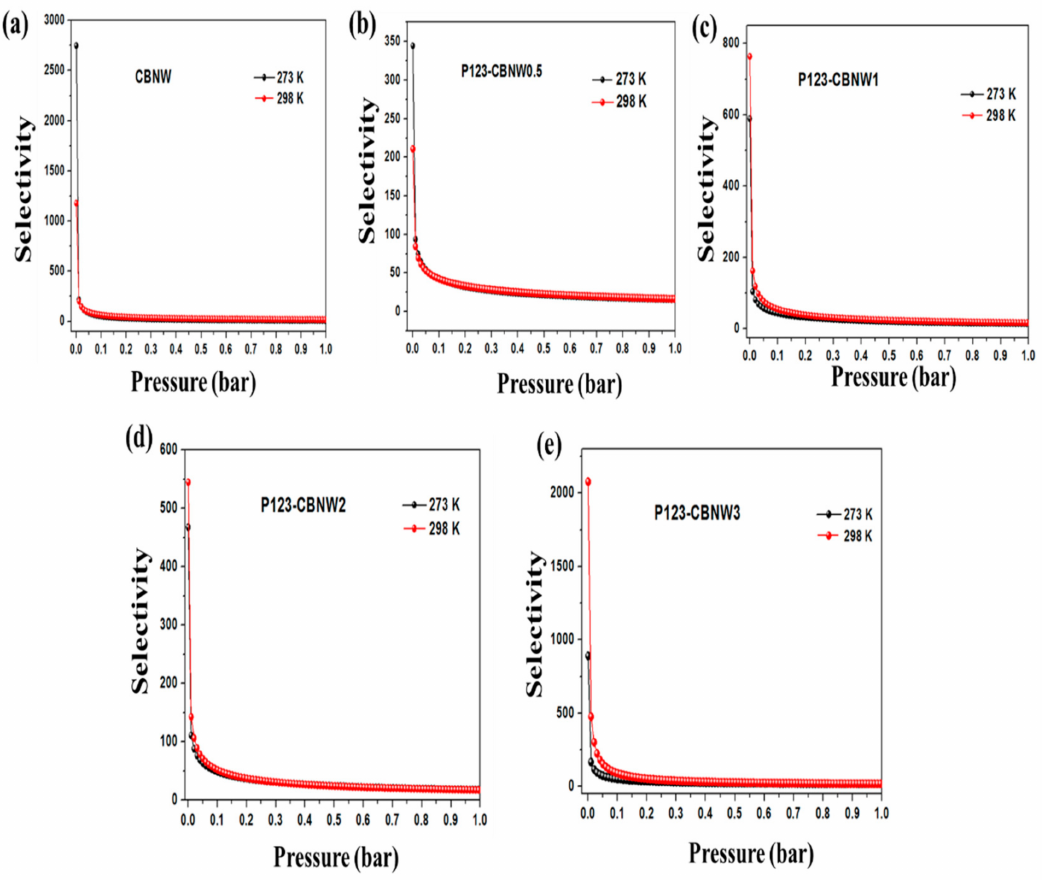
Figure 9. CO 2 / N 2 selectivity using ideal adsorbed solution theory (IAST) method of CBNW ( a ), P123-CBNW0.5 ( b ), P123-CBNW1 ( c ), P123-CBNW2 ( d ), and P123-CBNW3 ( e ) at 273 and 298